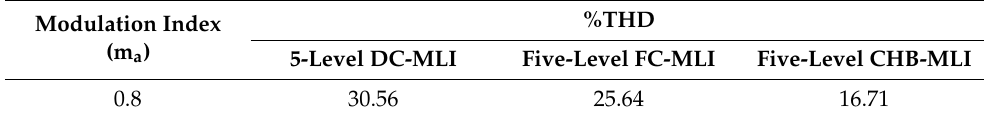
Table 7. Different inverters’ THDs compared.